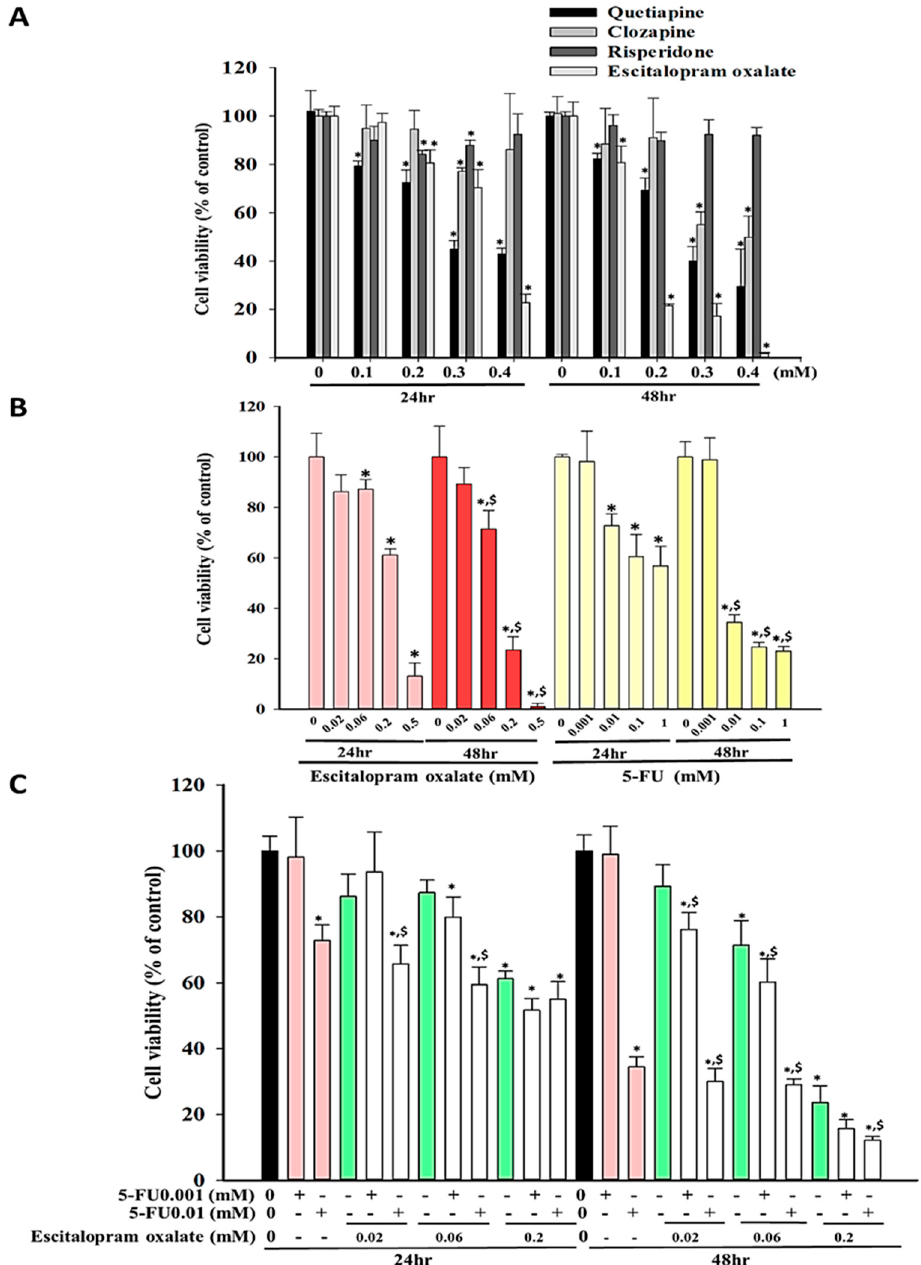
Figure 1. Effects of quetiapine, clozapine, risperidone, escitalopram oxalate, and 5 − FU on the survival of SNU − 1 cells. ( A ) The viability of SNU − 1 cells in the presence of quetiapine, clozapine, risperidone, and escitalopram oxalate for 24 and 48 hr. ( B ) The viability of SNU − 1 cells in the presence of escitalopram oxalate and 5 − FU for 24 and 48 hr. ( C ) The viability of SNU − 1 cells in the presence of the combinational use of escitalopram oxalate and 5 − FU for 24 and 48 hr. Statistical difference was calculated using one-way analysis of variance followed by Tukey’s multiple- comparisons test. The symbols * and $ indicate significant differences as compared with the control (0 mM) and escitalopram oxalate, respectively. The experiments were performed in triplicate. 5 − FU: 5 −